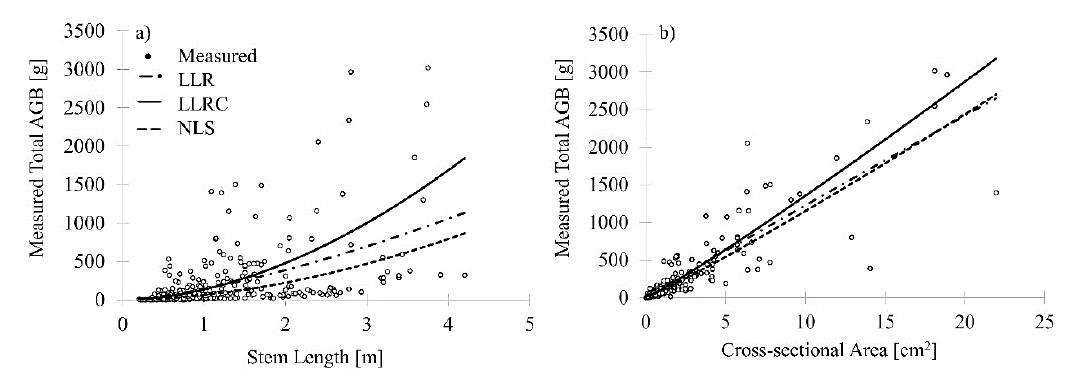
Figure 5. LLRC, LLR, and NLS model fits for the 2D predictor variable utilized to model total AGB for general shrubs and trees: ( a ) stem length and ( b ) cross-sectional area. Table 7. Regression coefficients to predict total AGB for general shrubs and trees with LLRC and NLS.